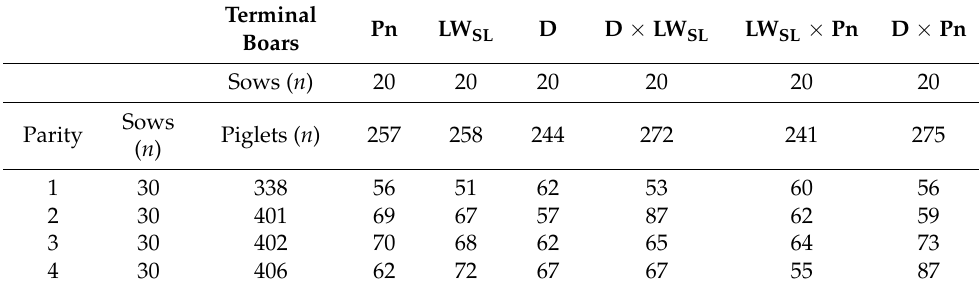
Table 2. Distribution of animals for analysis of growth of